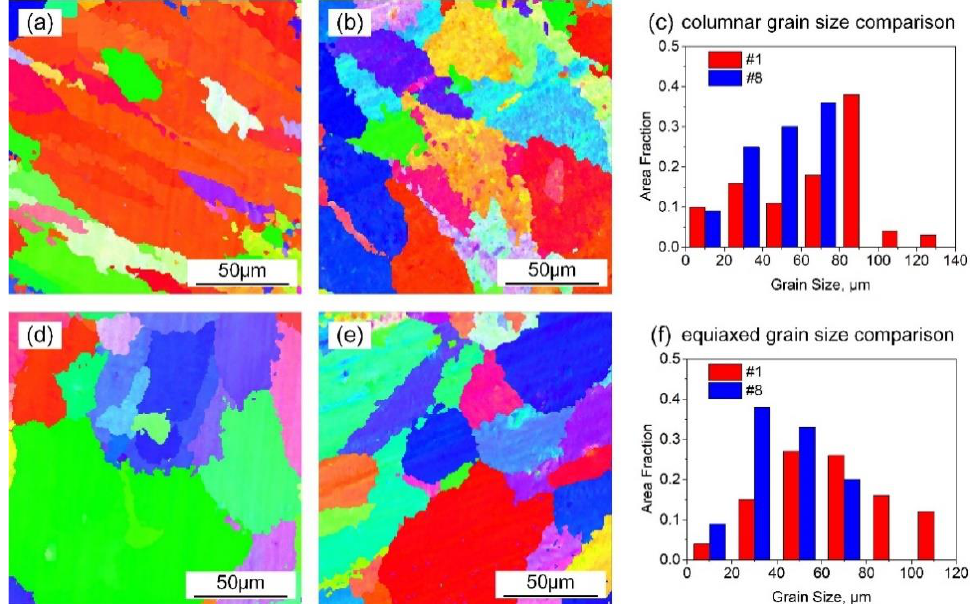
Figure 4. Microstructure near lock step, ( a ) cross section of lock bottom weld; ( b ) r = 0 mm, f = 0 Hz; ( c ) r = 0.6 mm, f = 50 Hz; ( d ) r = 0.6 mm, f = 200 Hz; ( e ) r = 0.6 mm, f = 350 Hz.